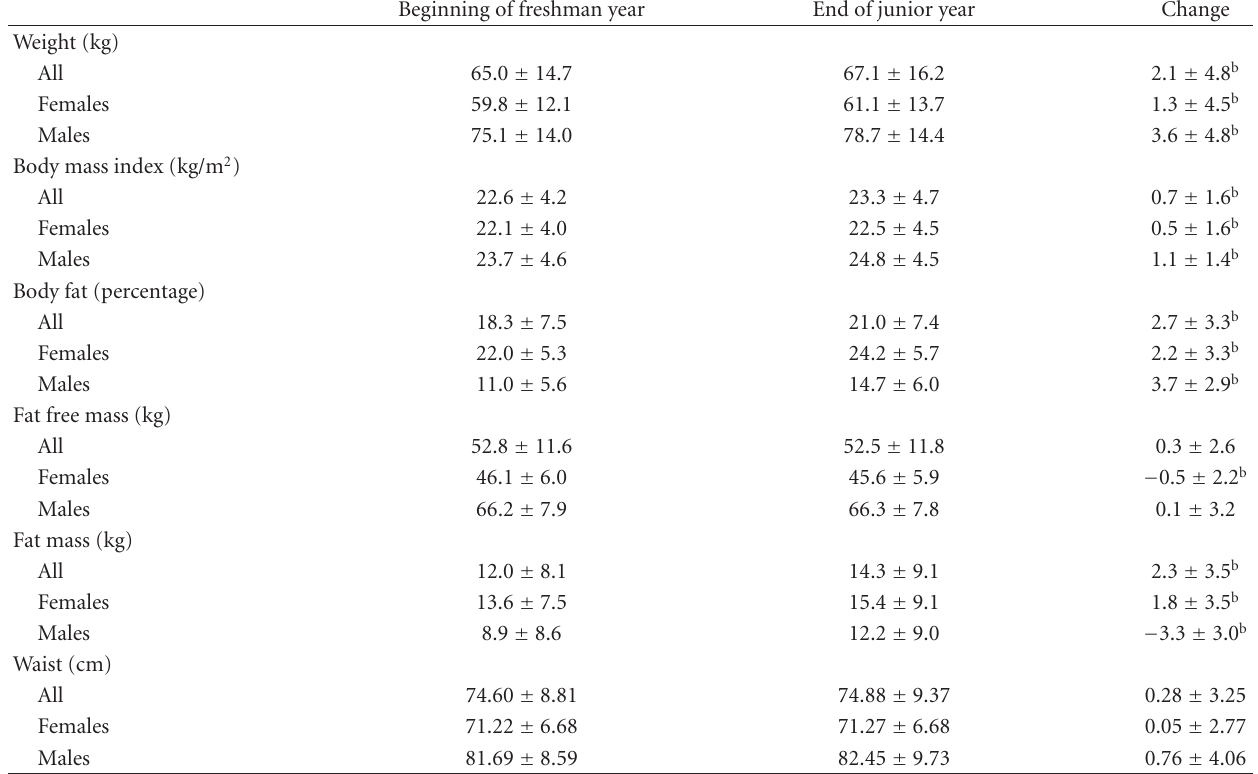
Table 2: Weight, body mass index, and body composition changes between the college freshman and junior years.